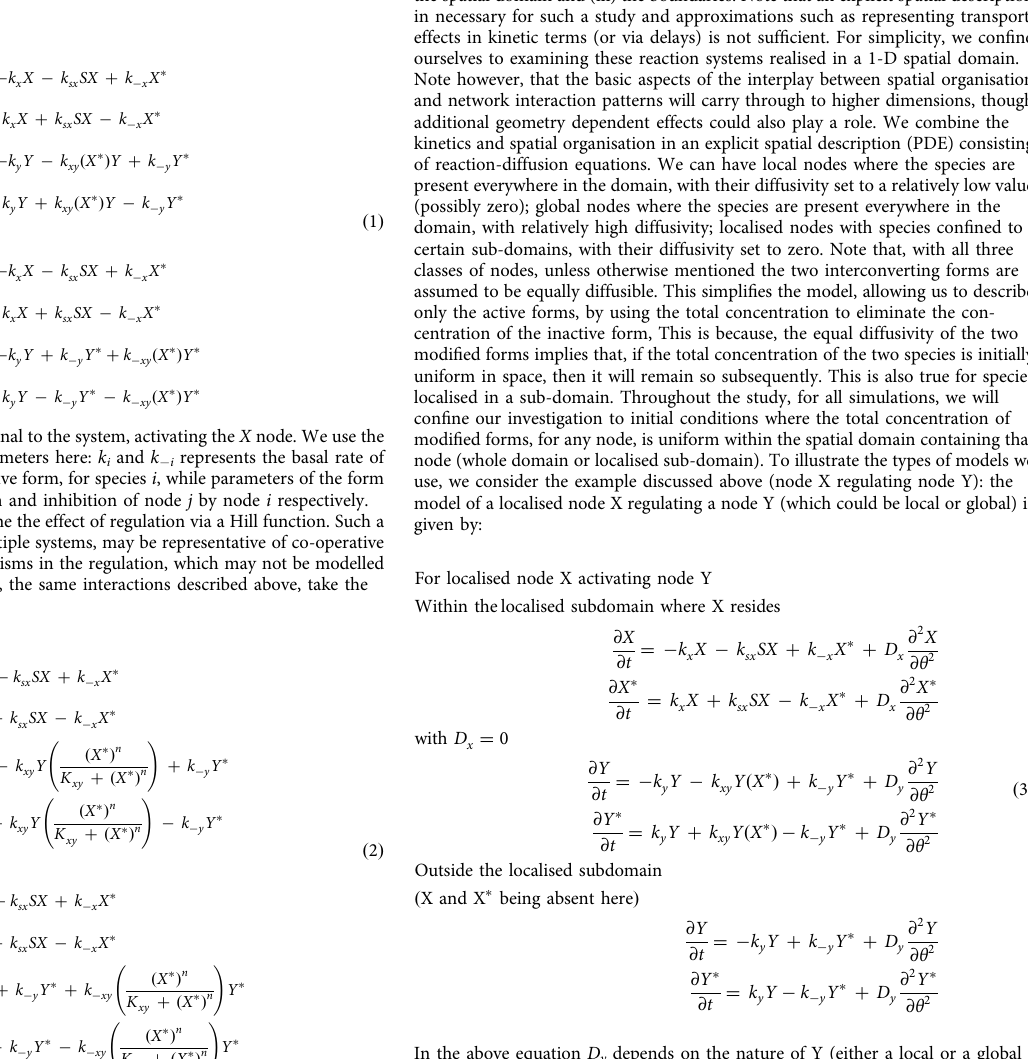
Fig. 10 A summary of the effects of localisation on networks. a Localisation of network components — nodes or interactions, can enable a network to exhibit new dynamical characteristics, otherwise inaccessible. A three-node motif exhibiting bistability with no localisation, can exhibit tristability when two of the interactions are localised in different parts of a spatial domain. b Localisation can circumvent kinetic constraints: ‘ spatial rewiring ’ of a network by localising a speci fi c node can enable bistability. Localisation of speci fi c nodes allows for this, while others do not (see design table), highlighting the value of a design approach. c Localisation of forward and backward regulation of a node allows for a spatially uniform steady state in the network. This can be destabilised giving rise to a spatial pattern, illustrating how localisation may be a potent tuneable dial for pattern formation. d Localisation can be deployed to create hybrid pattern-forming systems, combining features of gradient-driven patterns and (Turing mechanism-based) self-organised patterns. Aspects of the gradient are key to obtaining pattern formation, though they do not distort the pattern. e The presence of localisation can cause bistability in a negative feedback network to be incorrectly inferred (in an ODE framework) as a positive feedback. f The presence of localised components can introduce fundamental limitations in network inference based on ODE frameworks. We consider a network with and without localised components (the latter consistent with the ODE) and focus on nodes and measurements, revealing the underlying source of the disparity. With one of the nodes and one interaction localised (i) for the same type of measurement, some nodes are inconsistent with the ODE. (ii) for the same node, two types of measurements reveal opposite trends. g Spatial localisation can be a tool for modular combination of circuits (shown for bistable and oscillatory circuits), where a simple (kinetic) network combination does not work). h Localisation presents new dimensions to homoeostasis/adaptation which we explore: how localisation impacts (temporal) homoeostasis, how circuits can be designed for adaption to distance between locations, and how that is combined with adaption